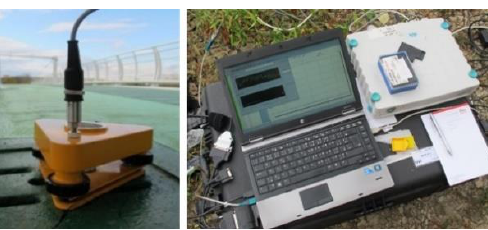
Figure 10. HBM B12/200 accelerometer at the middle (P02) of the bridge’s main span. Figure 10. HBM B12 / 200 accelerometer at the middle (P02) of the bridge’s main span.